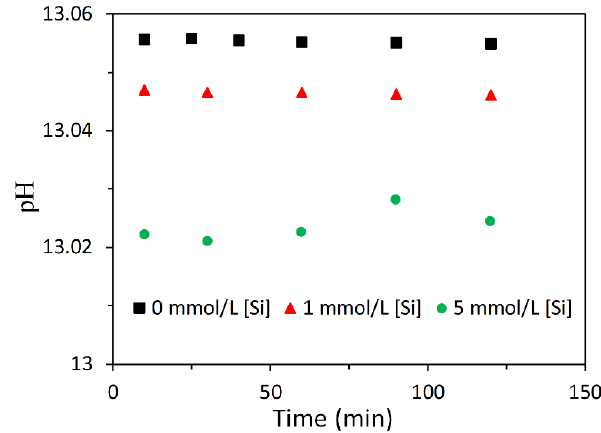
Figure 7. Calculated pH.